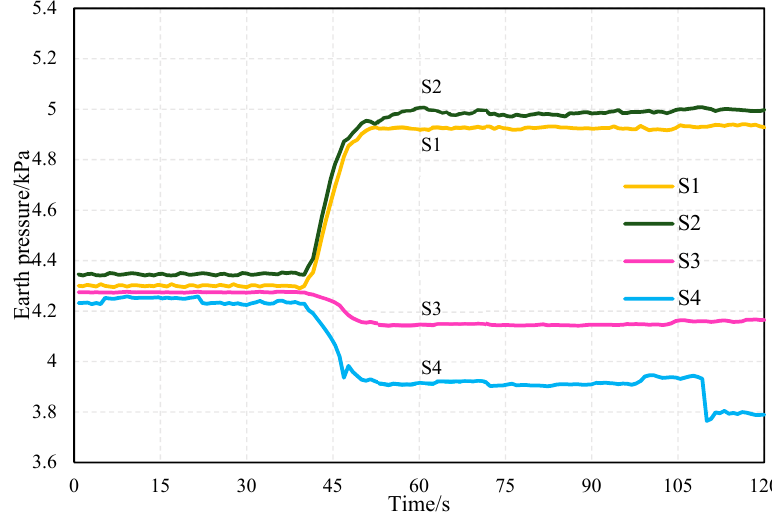
Figure 22. Measured soil pressure in Model 8-10.